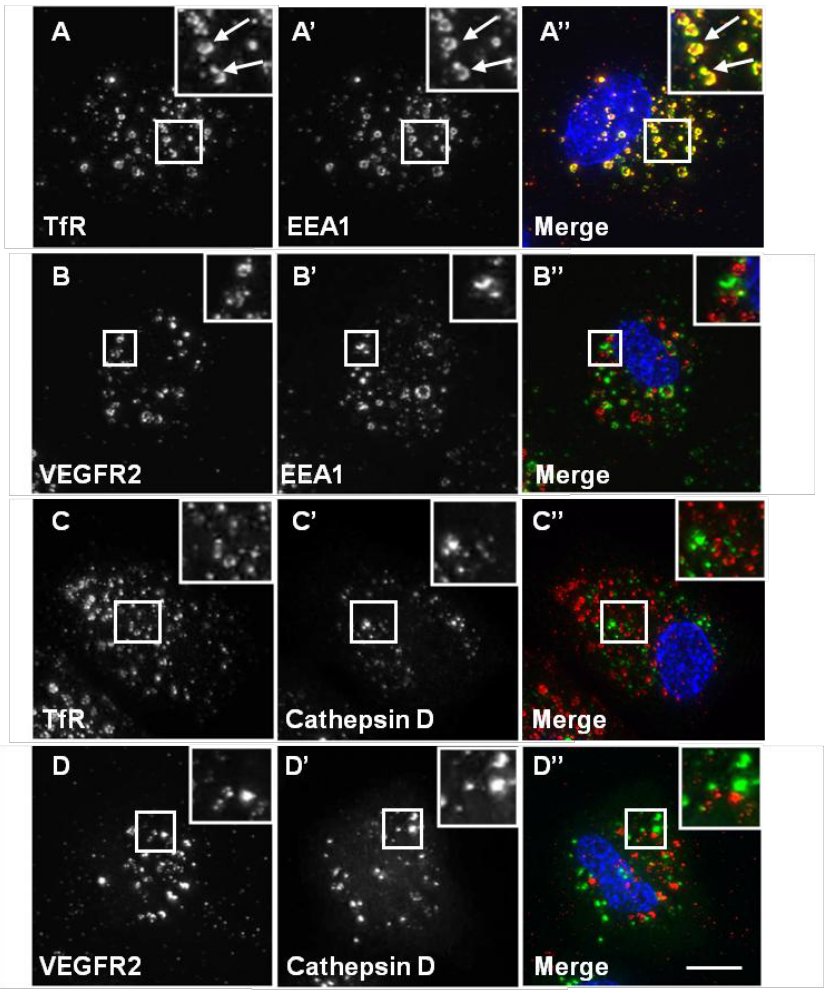
Figure 5. Chloroquine causes TfR, but not VEGFR2, accumulation in endosomes. A direct recycling assay was performed using the goat anti-VEGFR2 extracellular domain or mouse anti-TfR (red). Samples were fixed, permeabilised and labelled with either rabbit anti- EEA1 (green) or rabbit anti-cathepsin D (green). Primary antibodies were visualised using either FITC anti-rabbit IgG or AlexaFluor-488-conjugated anti-rabbit IgG, and the nucleus was seen with DAPI (blue). The images are 2D projections of a stacked series of 15–30 μm optical sections taken using a wide field deconvolution microscopy system. Insets show a two-fold magnification of the indicated region. Bar: 10